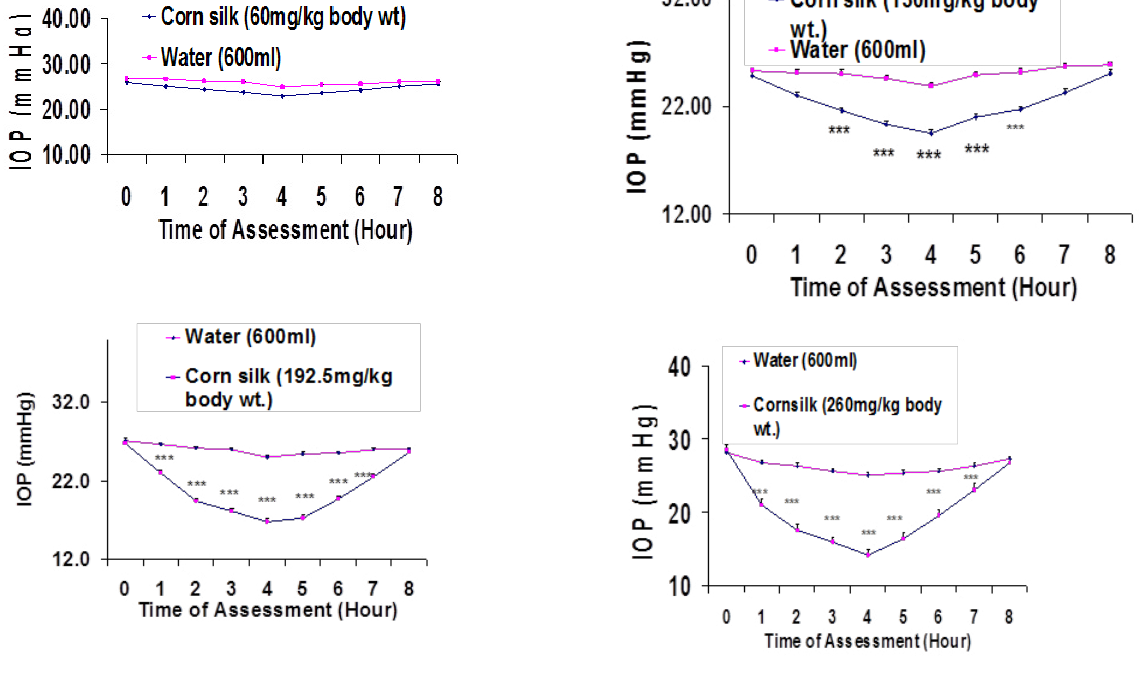
Figure 1 : The mean difference in IOP was significant (p<0.001) after administering 130 mg/kg, 192.5 mg/kg and 260 mg/kg body wt. of CSAE, across different time of assessment in right eye of ocular hypertensives. Maximum fall in mean IOP was after four hours.